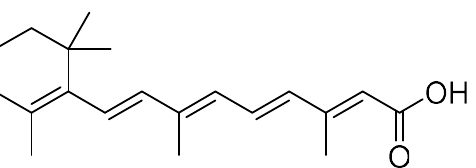
Figure 7. Retinoid: metabolite with an insecticidal and antifeedant effect.